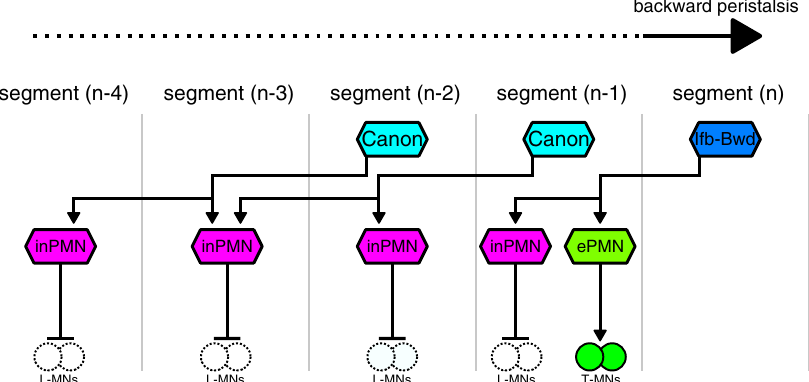
Fig. 7 A model of early- and late-phase motor inhibition mediated by Ifb-B and Canon neurons during backward locomotion. When the wave front reaches the segment ( n ), Ifb-Bwd neurons in segment ( n ) and Canon neurons in segment ( n − 1) and segment ( n − 2) are activated. Ifb-Bwd and Canon neurons in turn activate inhibitory premotor neurons (inPMN) innervating L-MNs in segment ( n − 1) and in segments ( n − 2) to ( n − 4), respectively, via their ascending axons. Ifb-Bwd neuron activates excitatory premotor neurons (ePMN) that innervate T-MNs. Neurons outlined by dotted or solid lines indicate inactive or active neurons, respectively. Arrows with fi lled heads indicate excitatory synapses while those with bar heads indicate